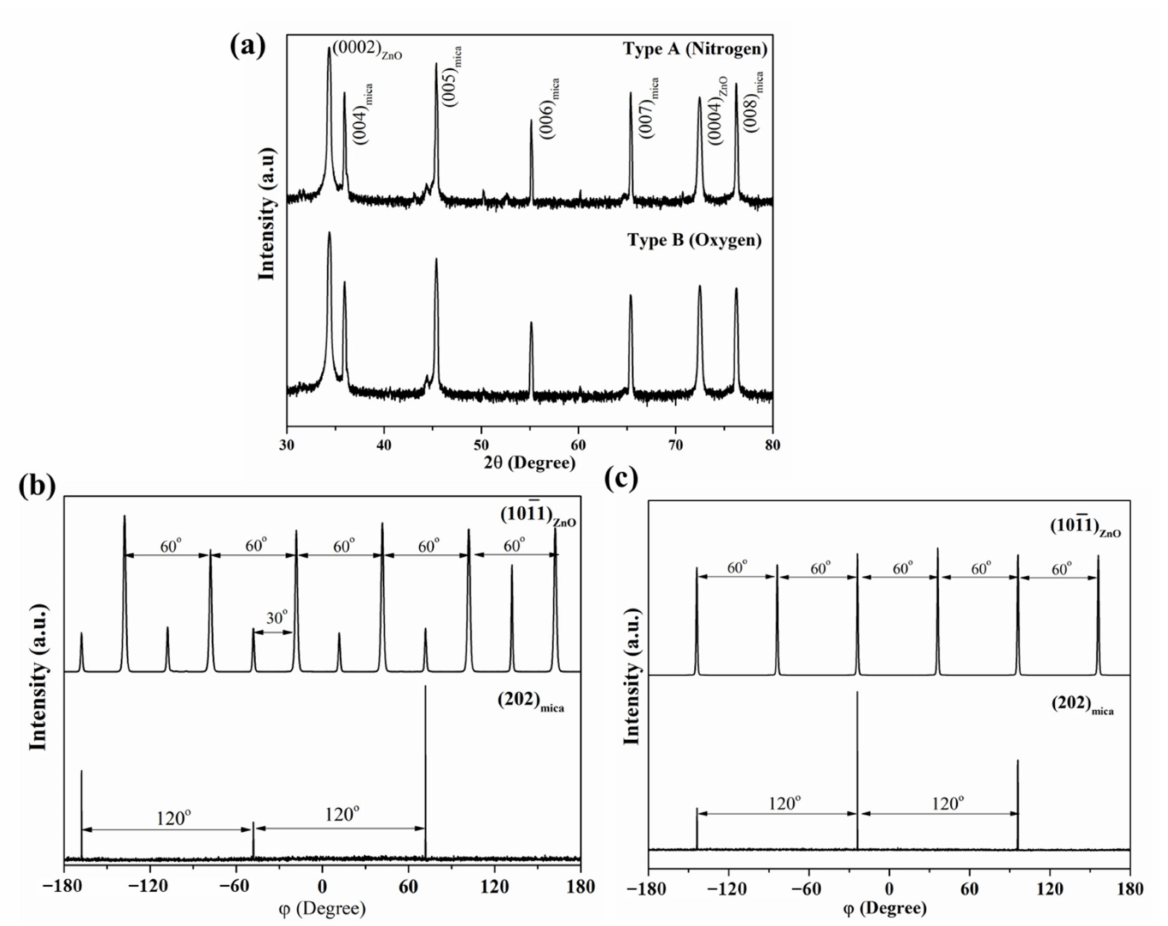
Figure 9. ( a ) XRD θ -2 θ profiles of ZnO layers hydrothermally grown on Type A and Type B seeds. XRD ϕ -scan of the ZnO {1011} and mica {202} reflections for ZnO layers grown on ( b ) Type A and ( c ) Type B seeds, respectively.